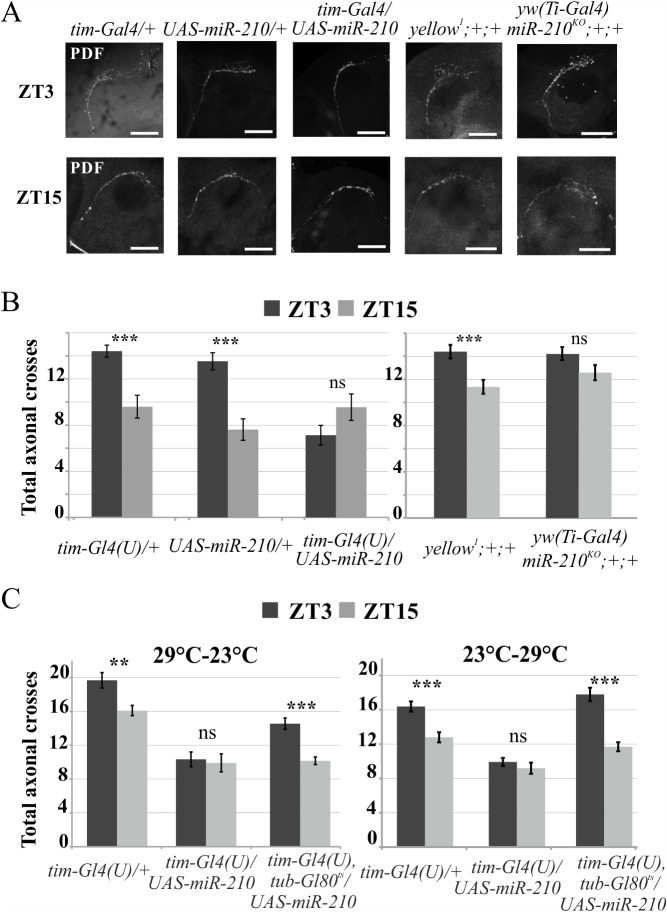
Effects of miR-210 manipulation on s-LNvs axon termini.(A) Confocal stack images representing the s-LNvs organization at ZT3 (defasciculate state) and ZT15 (fasciculate state). PDF immunostaining was performed on miR-210 over-expressing flies (tim-Gl4(U)/UAS-miR-210) or on yw(Ti-Gal4)miR-210KO;+;+ flies and their controls (tim-Gl4(U)/+, UAS-miR-210/+ and yellow1;+/+). Scale: bar 50 μm. (B) Quantification of total s-LNvs axonal crosses of the aforementioned genotypes, performed on confocal stacks images, as described in the Methods. (C) Quantification of total s-LNvs axonal crosses in flies with miR-210 over-expression (tim-Gl4(U),tub-Gl80ts/UAS-miR-210/+) restricted only during development (29°C-23°C), or only during adulthood (23°C-29°C), with respect to positive (constitutive over-expression, tim-Gl4(U)/UAS-miR-210) and negative (tim-Gl4(U)/+) controls. Over-expression was modulated by using the Gal4-Gal80ts-UAS ternary system. Mean ± SEM. Mann-Whitney U test: *** p<0.005, **p<0.01; ns: not significant. (Dark grey bar: ZT3, light grey bar: ZT15).